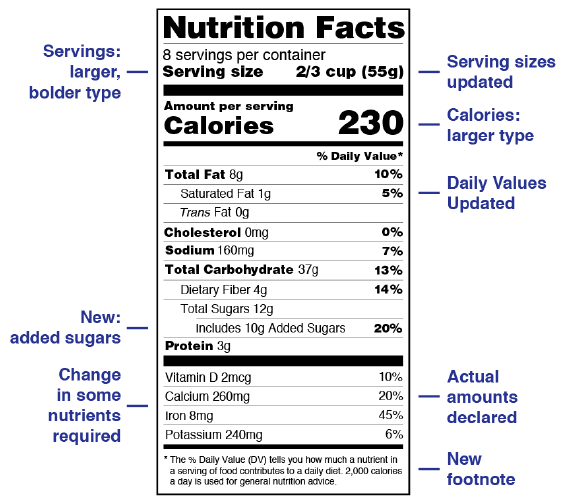
Figure 1. Nutrition fact label format that includes raw totals of nutritional components along with recommendations to the consumer based upon these data. Modified from [14].